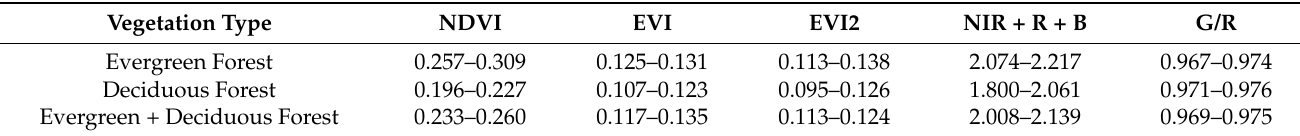
Table 1. The value range of each greenness characteristic derived from different vegetation indices within the 30 days before the spring average pollen allergy outbreak date during 2011–2021.